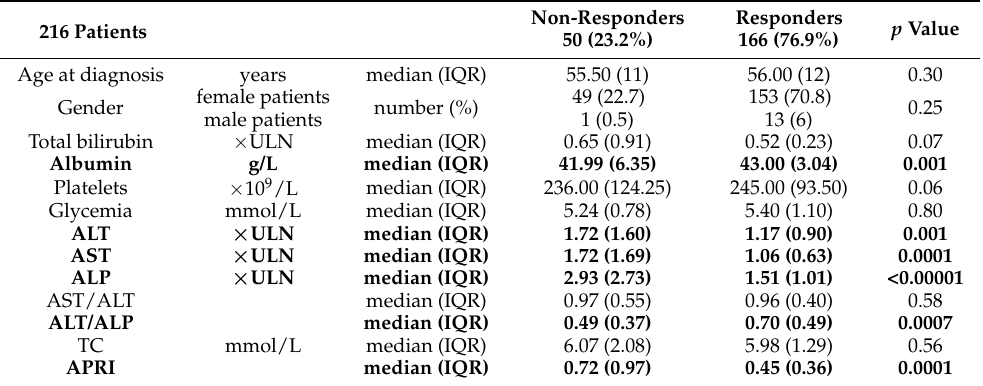
Table 4. Pretreatment differences in clinical and demographic characteristics between responders and non-responders (response evaluated after 12 months of UDCA treatment).